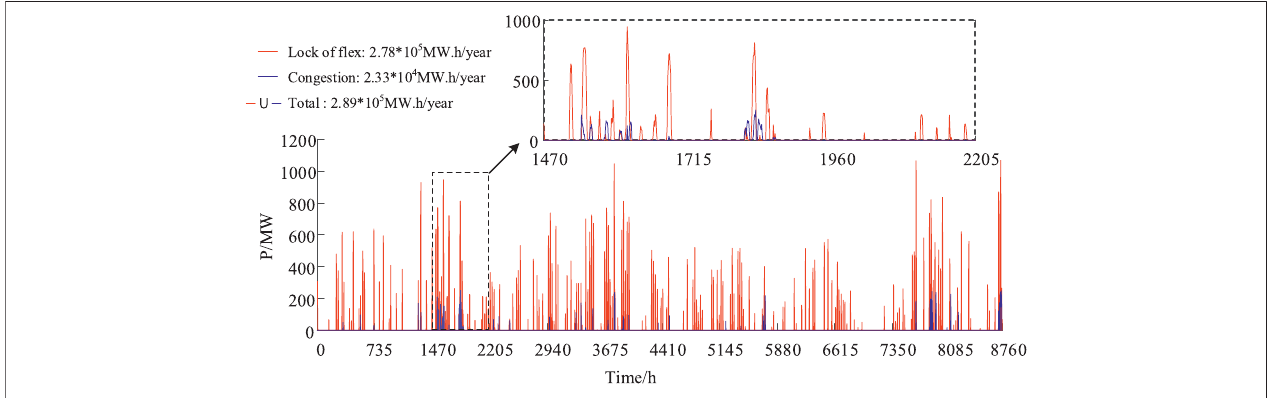
FIGURE 8 | Coupling relationship of wind curtailment with an engineering value of transmission capacity.